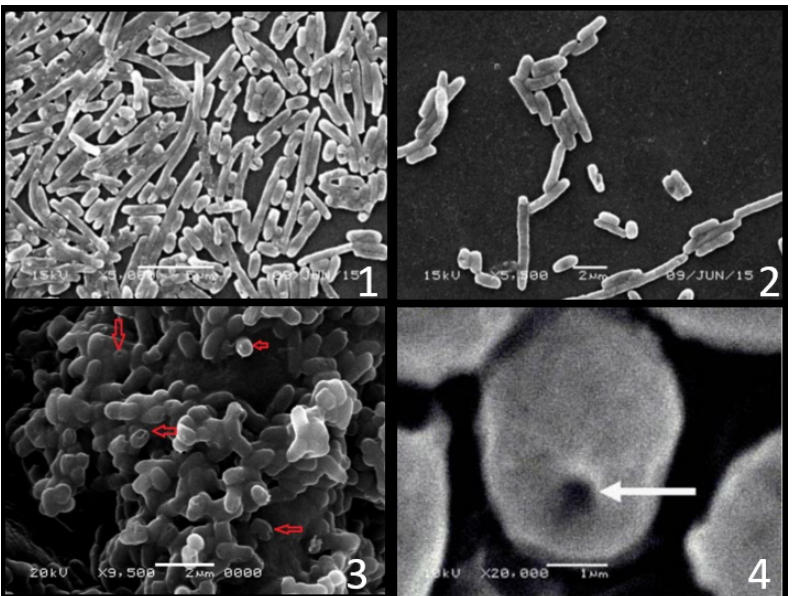
Figure 2. Electron microscope for the BGs at 5000× prepare by Sponge-Like protocol and sponge like reduced protocol using ( 1 , 2 ), tween 80 ( 3 ) and Lysis gene E. ( 4 ).